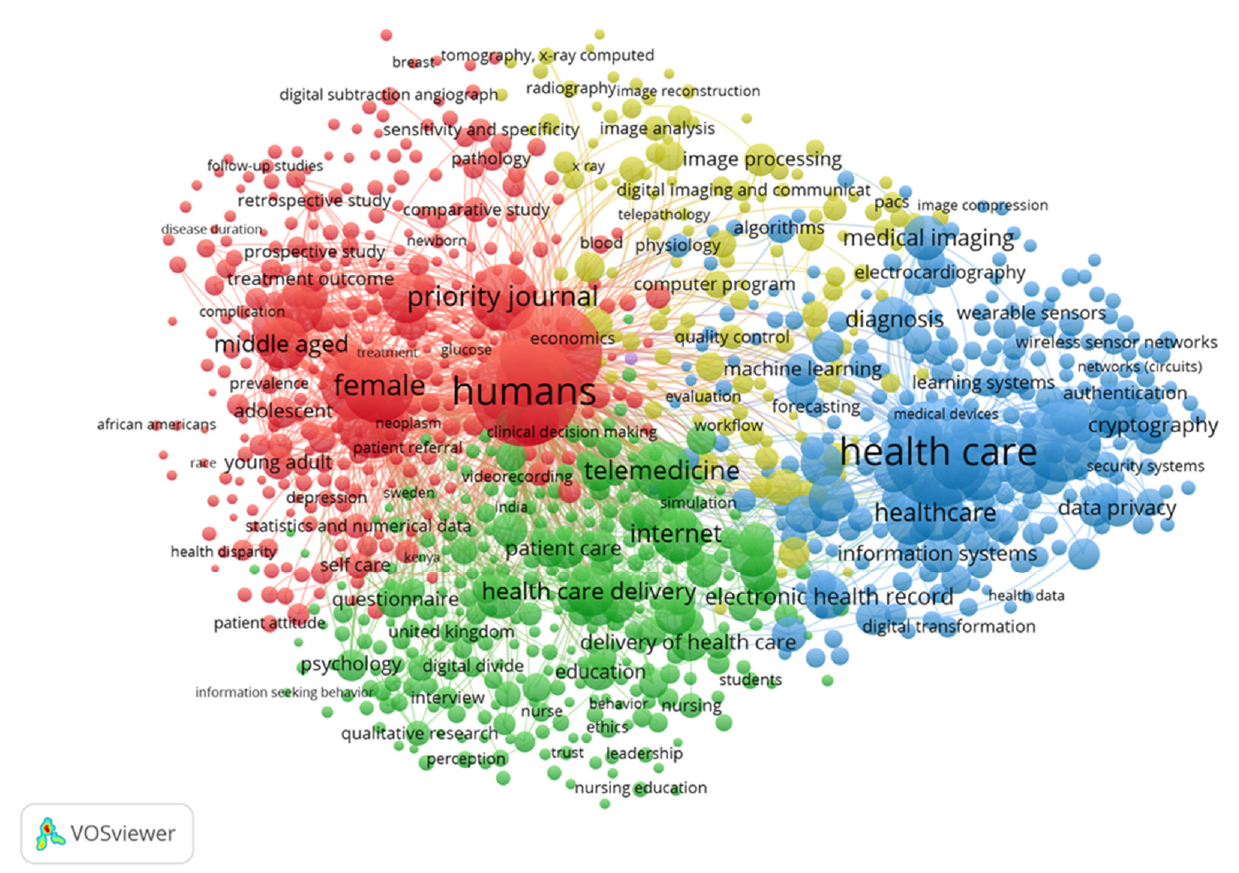
Figure 8. The cluster view of the keyword network on digital healthcare.